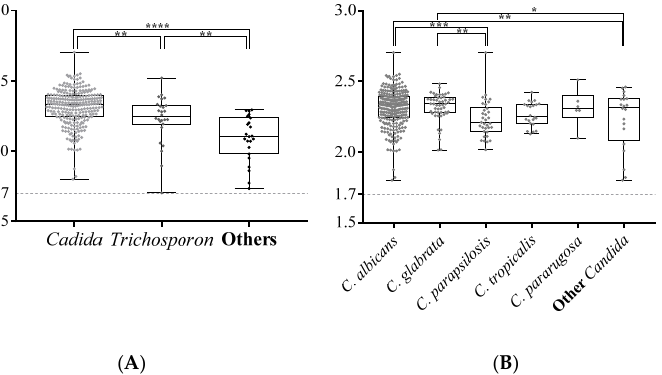
Figure 3. The log(score) values for yeast isolates that are identified using the MALDI-TOF Bruker Biotype. The Biotyper log(score) values for Candida , Trichosporon, and other genuses are compared in ( A ). All scores for the isolates of the Candida species that are identified by this study are compared ( B ). The box plots show the diversity of the log(score) values for the yeast isolates. The upper and lower edges of the boxes correspond to the first and third quartiles. The median is represented by a horizontal line within the box. The whiskers extend from the box in order from the highest to lowest. Each score is marked by a dot. The log(score) values are compared using an unpaired Student’s t -test; a p -value <0.05 is represented as *, <0.01 as **, <0.001 as ***, and <0.0001 as